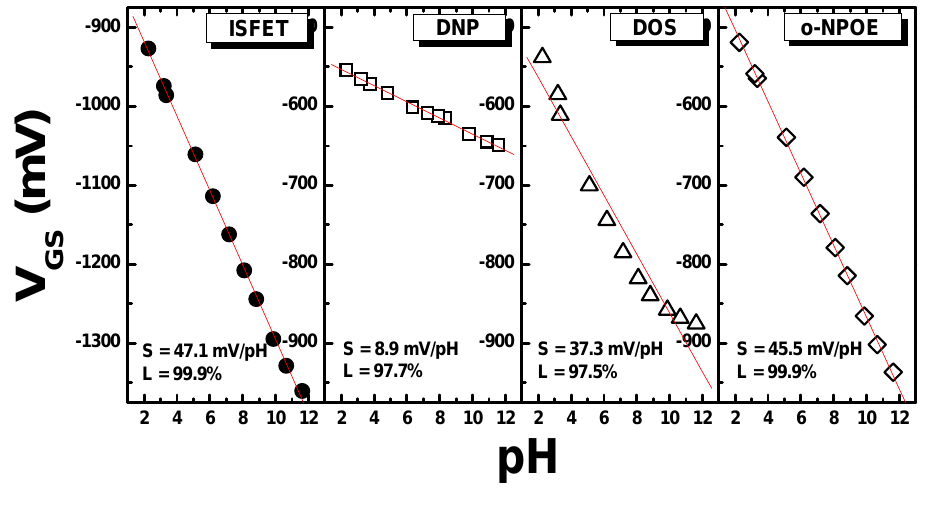
Figure 2. pH sensitivity of (a) a Si membranes containing different plasticizers at 70 wt.% composition: (b) DNP, (c) DOS, and (d) o -NPOE.